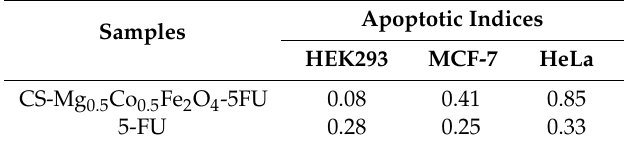
Table 4. Apoptotic indices of free 5-FU and 5-FU-loaded